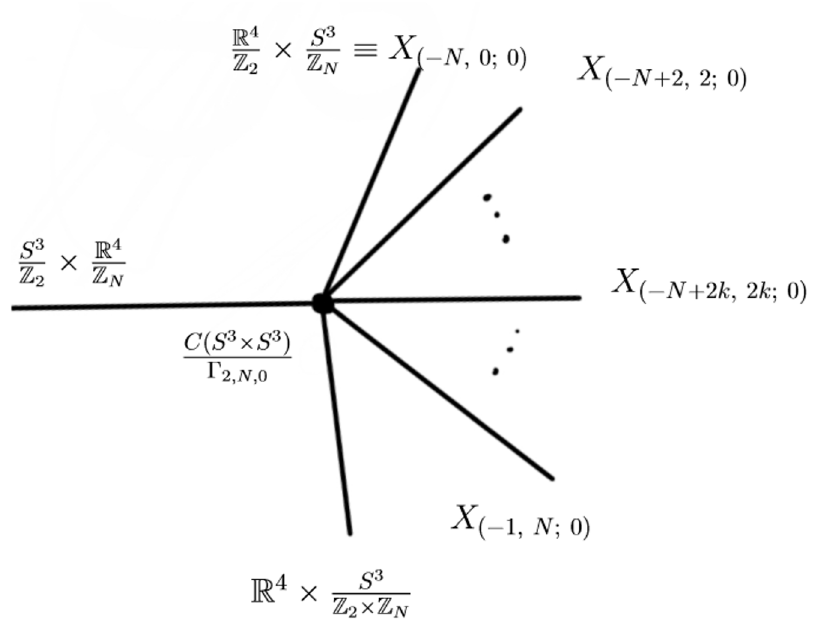
Figure 7. The classical moduli space for p = 2 , N odd, and q = 0 . L 2 -integrable harmonic 2 -forms on each of these branches is exactly p − 1 , matching the number of free U(1) factors on the UV